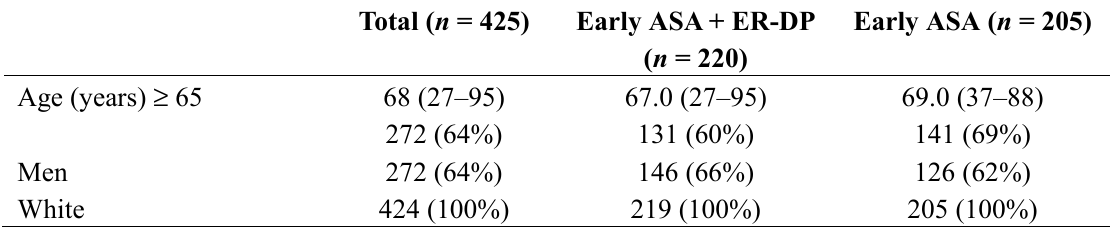
Table 1. Demographics and baseline